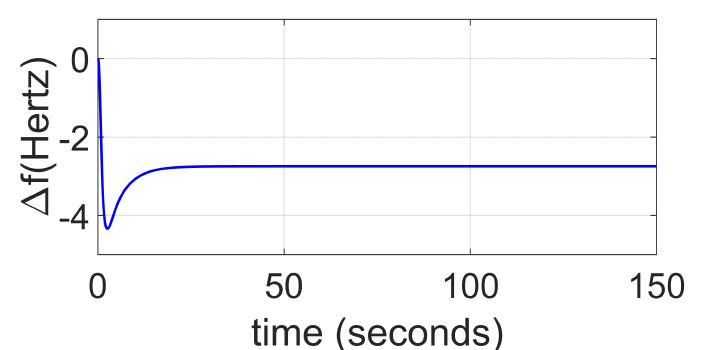
Figure 10. Frequency measurement under positive bias injection attack.